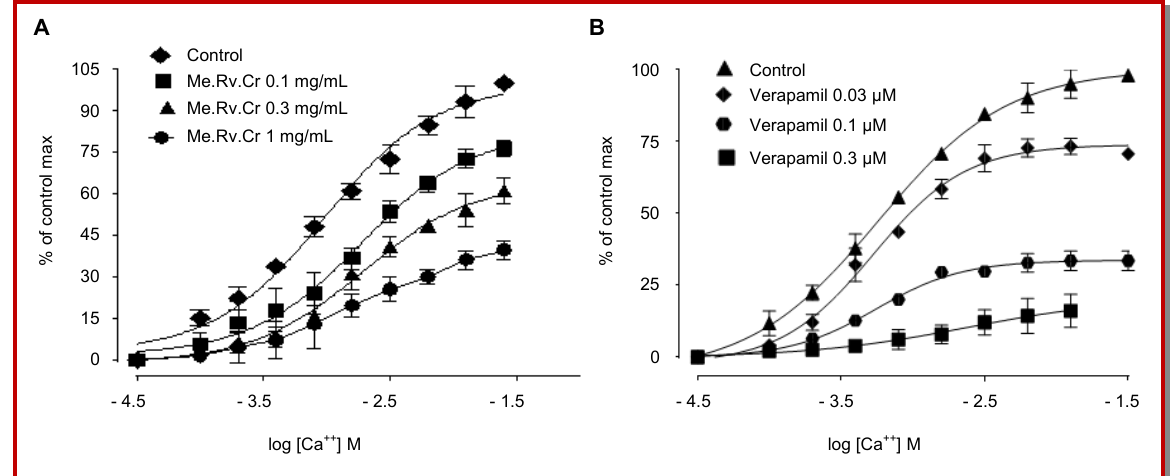
Figure 2 : Effect of the R. vesicarius on concentration-response curve of Ca 2+ on isolated rabbit jejunum preparations (A), and effect of the verapamil (standard) on concentration – response curve of Ca 2+ on isolated rabbit jejunum preparations (B); Values are expressed as mean ± S.E.M.;